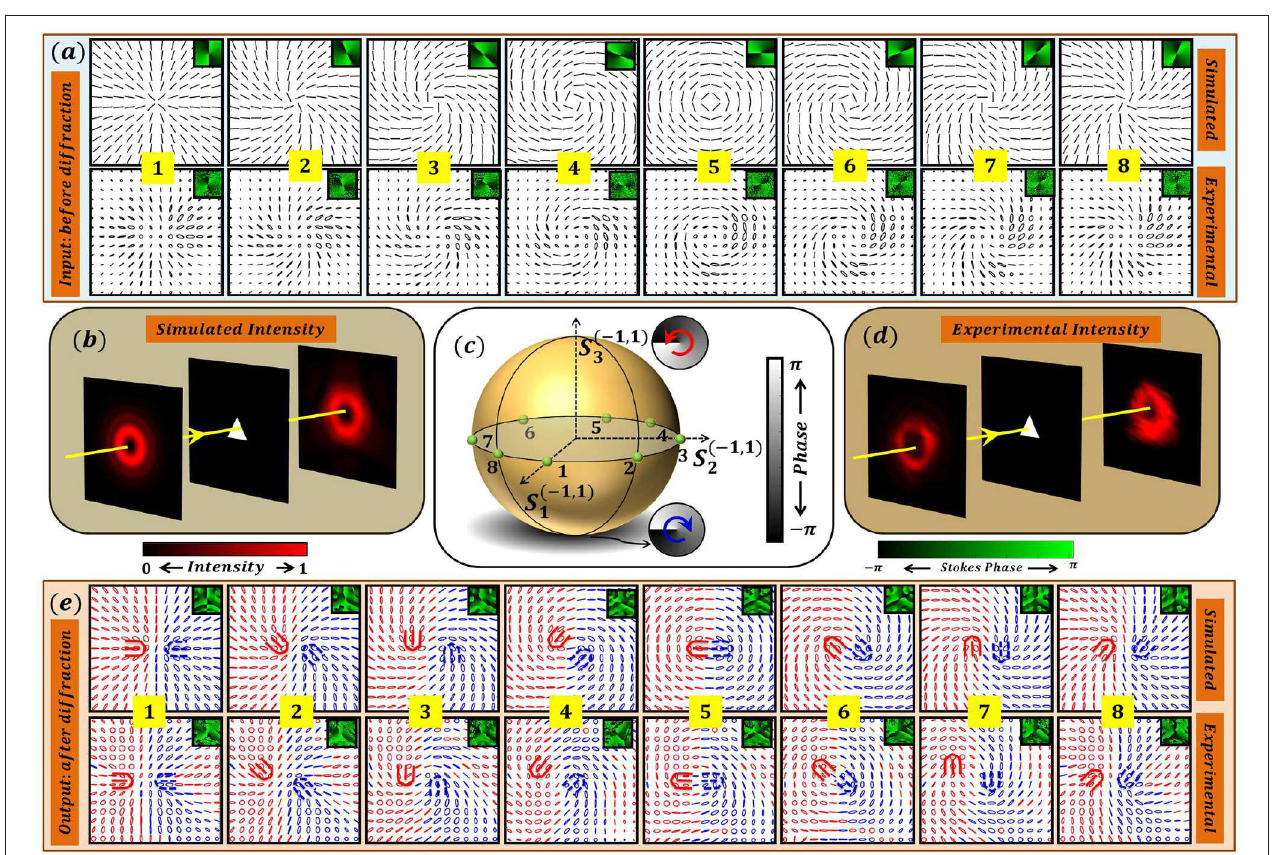
FIGURE 12 | Intensity degeneracy in Fraunhoffer diffraction of V-point beam with index η = + 1 through a triangular aperture. (a) Simulated and experimentally recorded input polarization distributions corresponding to points 1 − 8 marked on a HOPS in (c) . Note that all these distributions lie at the equator of a HOPS and have same polarization singularity index η = + 1. (b) Simulation: Schematic of the setup with Input intensity, aperture, and diffracted intensity. (d) Experimentally recorded input and far field intensity. (e) simulated and experimentally observed polarization patterns after the diffraction through aperture. Note that for each of the input SOPs marked on HOPS, the diffracted intensity exhibit degeneracy. Further each of the input V-point distribution disintegrates into two lemons (each with index I c = + 1 / 2) of opposite handedness upon diffraction.